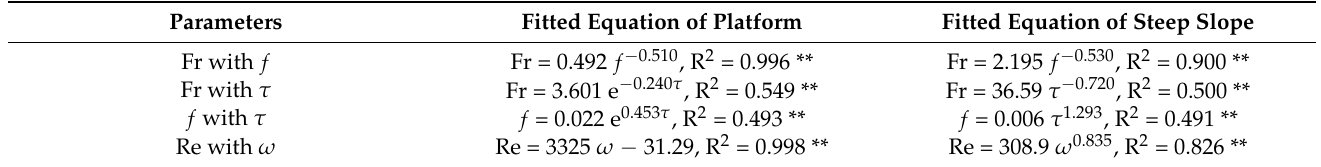
Table 2. Correlation of hydraulic